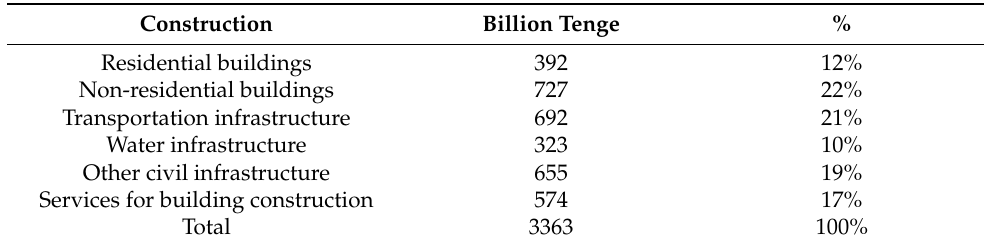
Table 3. Economic values of construction activities (the average of 2015–2019) (own elaboration based on)